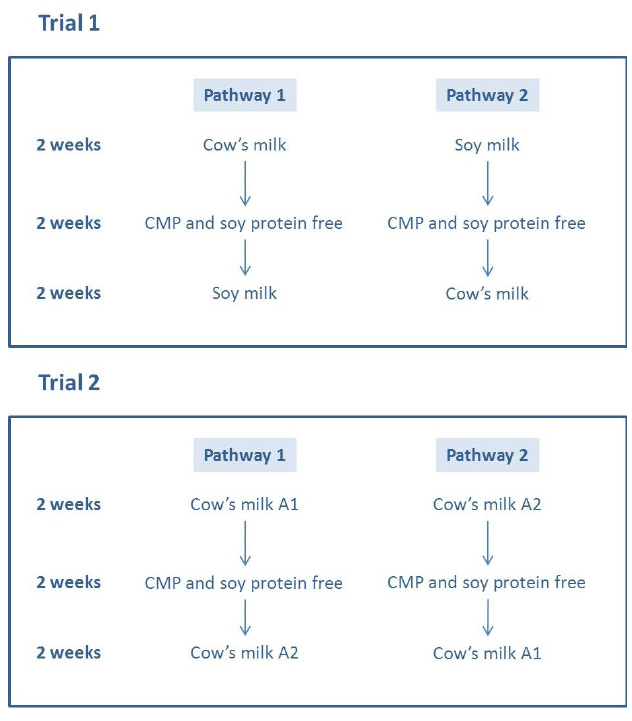
Figure 1. Trials and pathways to which participants were assigned in the cross-over